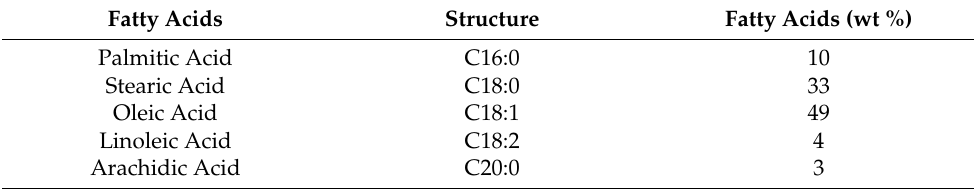
Table 3. Fatty acid composition of mango seed